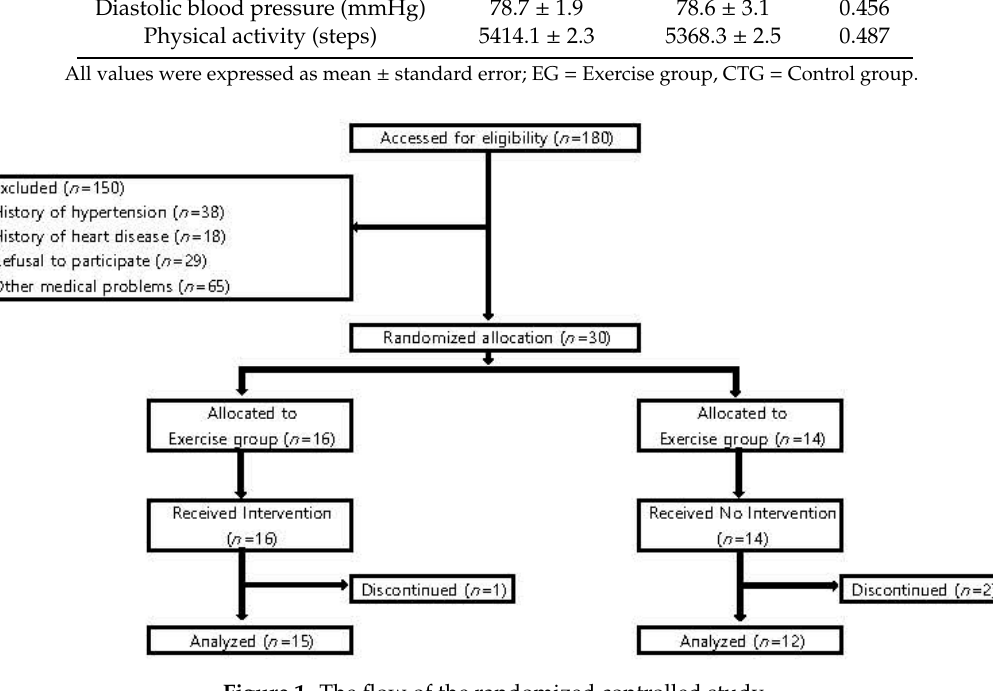
Table 1. Physical and physiological characteristics of subjects.